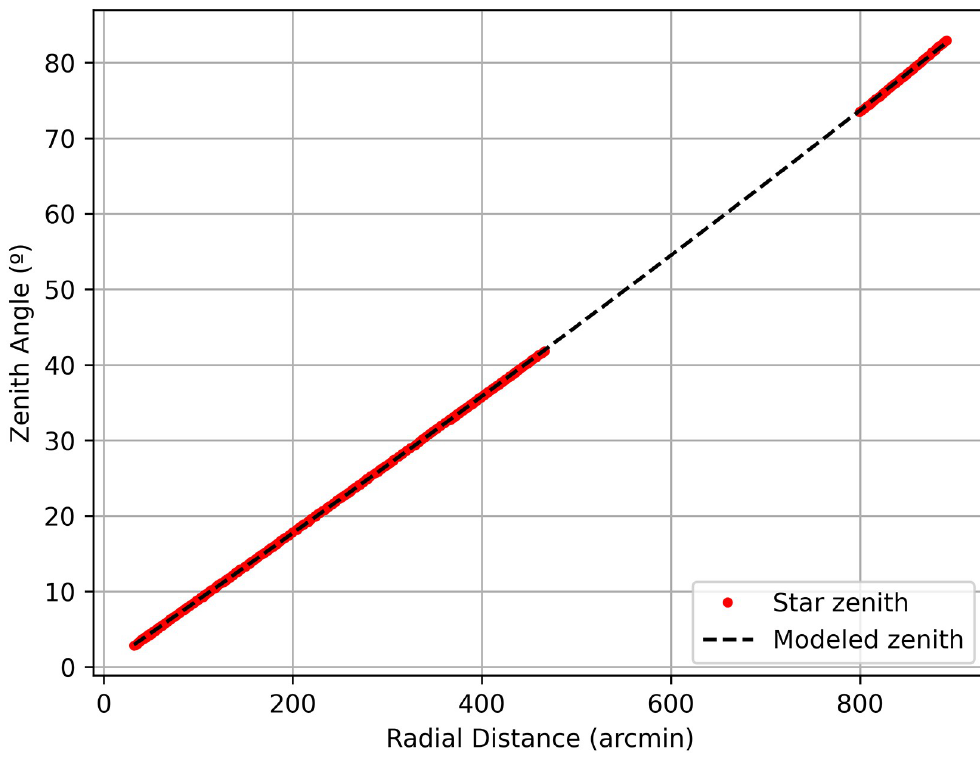
Fig 4. Relationship between zenith angle and radial distance with polynomial adjustment of degree